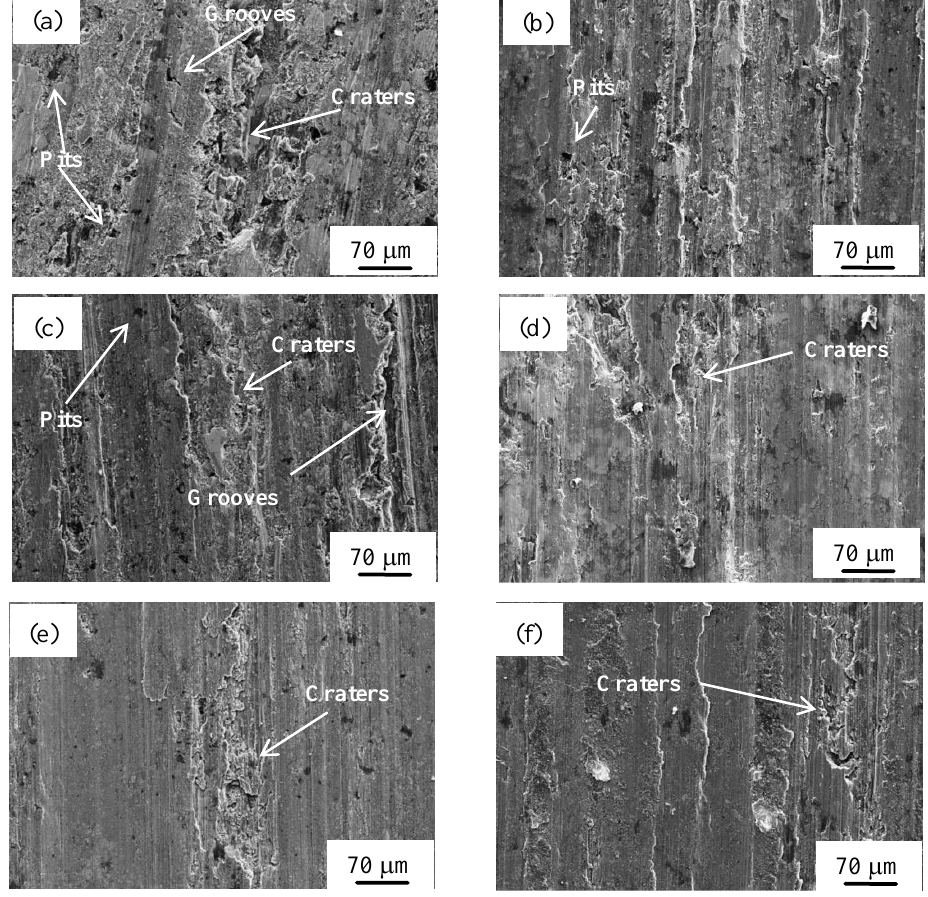
Figure 5. SEM micrographs of (B 4 C+Ti)/Mg ( a , c , e ) and (B 4 C+Ti)/AZ91D ( b , d , f ) composites prepared for 30min ( a , b ), 90min ( c , d ) and 180min ( e , f ).